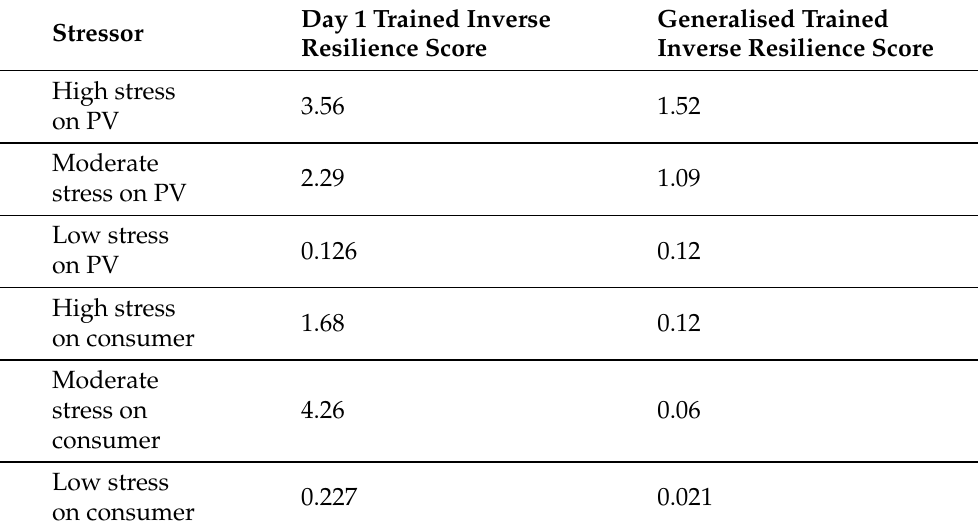
Table 11. Inverse resilience scores for single day training and generalised training.